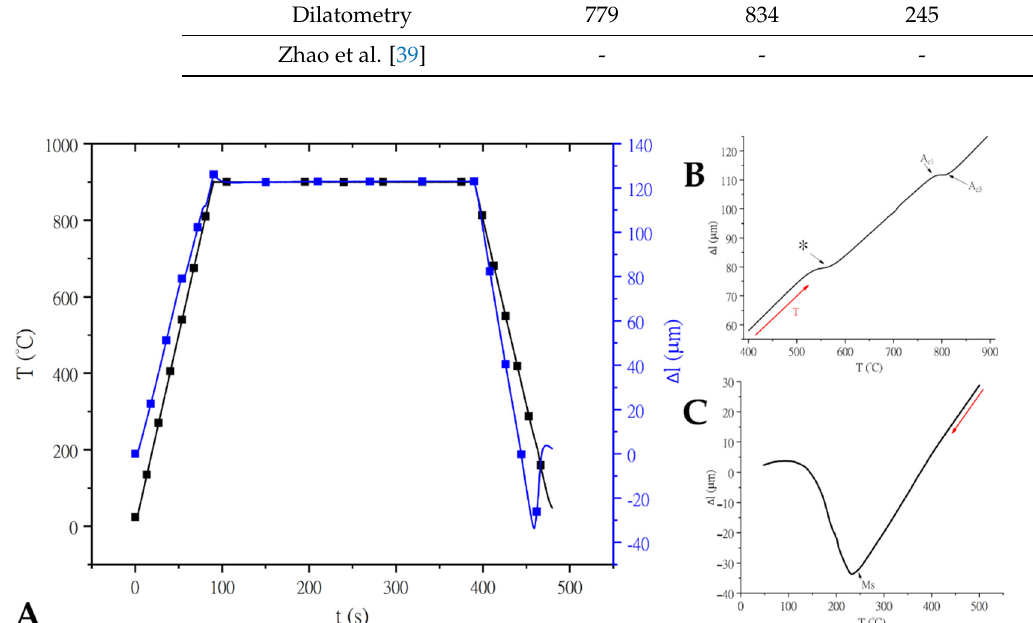
Figure 2. ( A ) Thermal cycle for the dilatometric study of critical temperature Ac1, Ac3, Ms (black line), and dilatation curve (blue line); ( B ) relative change in length against temperature curve indicating austenitisation transformation and the temperature Ac1 and Ac3; the star (*) = indicates cementite precipitation during heating of martensite due to carbon rejection; ( C ) cooling branch of the thermal cycle indicating Ms temperature and martensitic transformation.